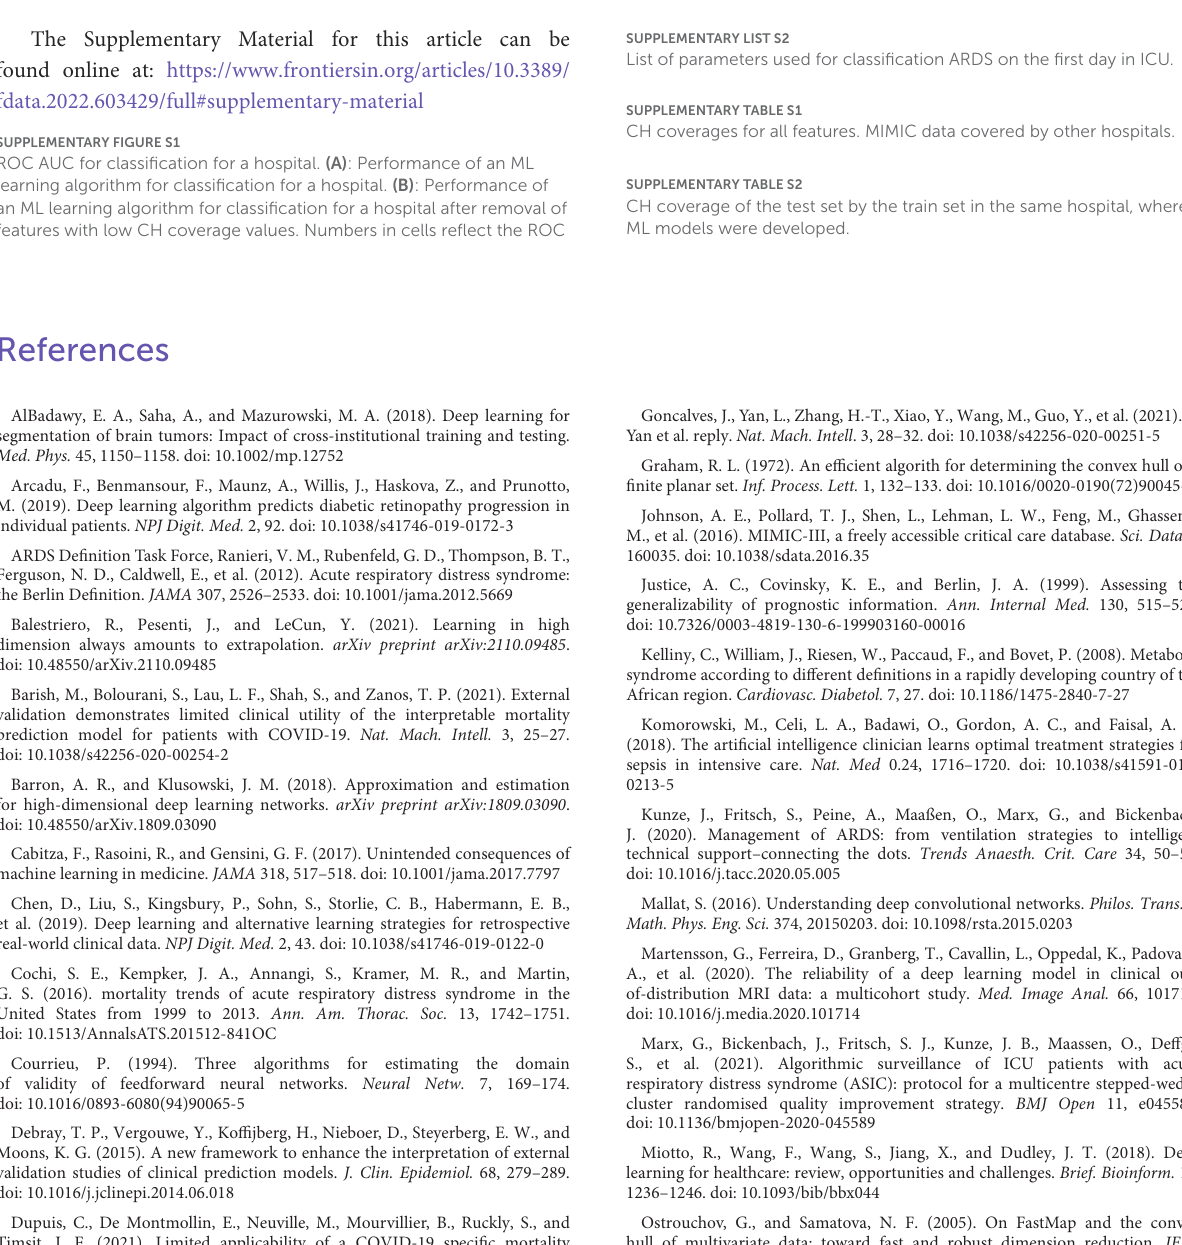
SUPPLEMENTARYLISTS2 List of parameters used for classification ARDS on the first day in ICU.